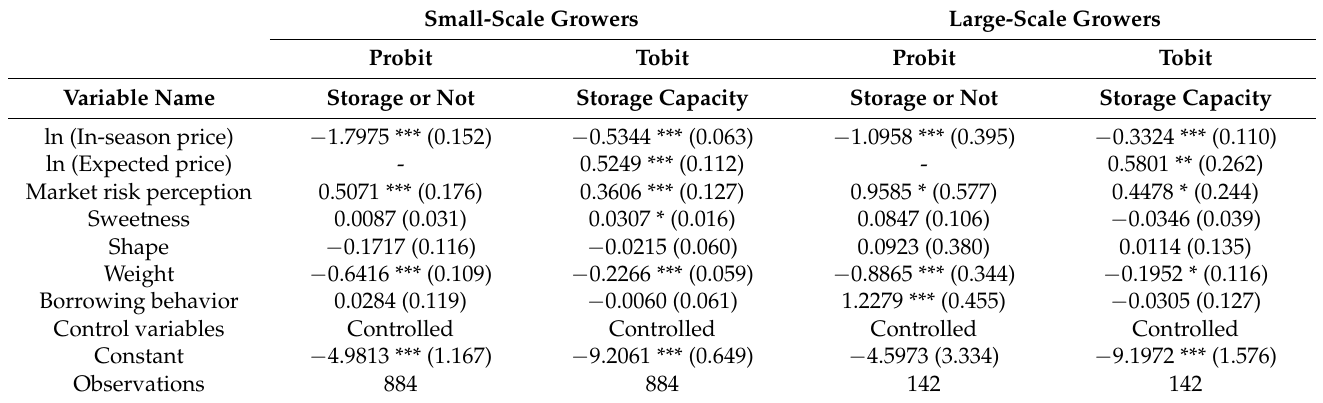
Table 5. Regression results of storage decision behavior of growers of different scales.